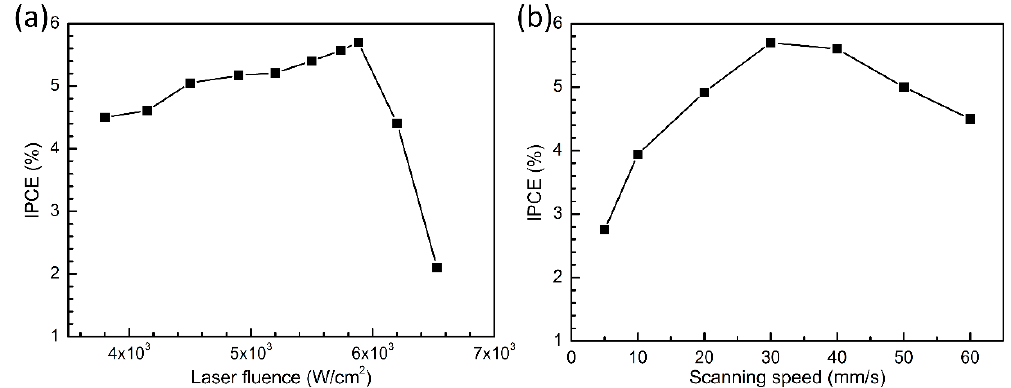
Figure 4. Effect of ( a ) laser power density and ( b ) scanning speed on the IPCE of the flexible DSCs based on laser sintered TiO 2 films.